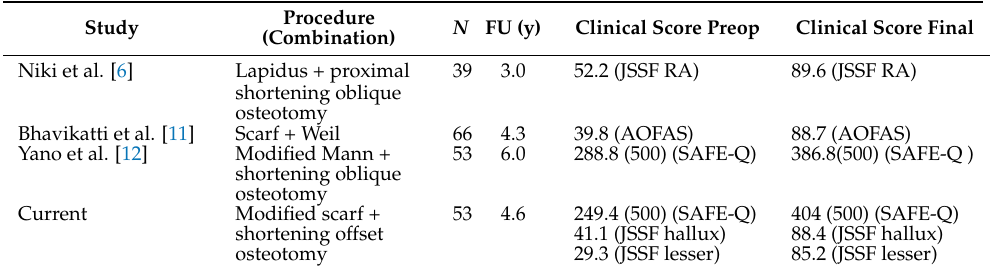
Table 8. Comparisons between current study and other studies of combined joint-preserving surgery in RA